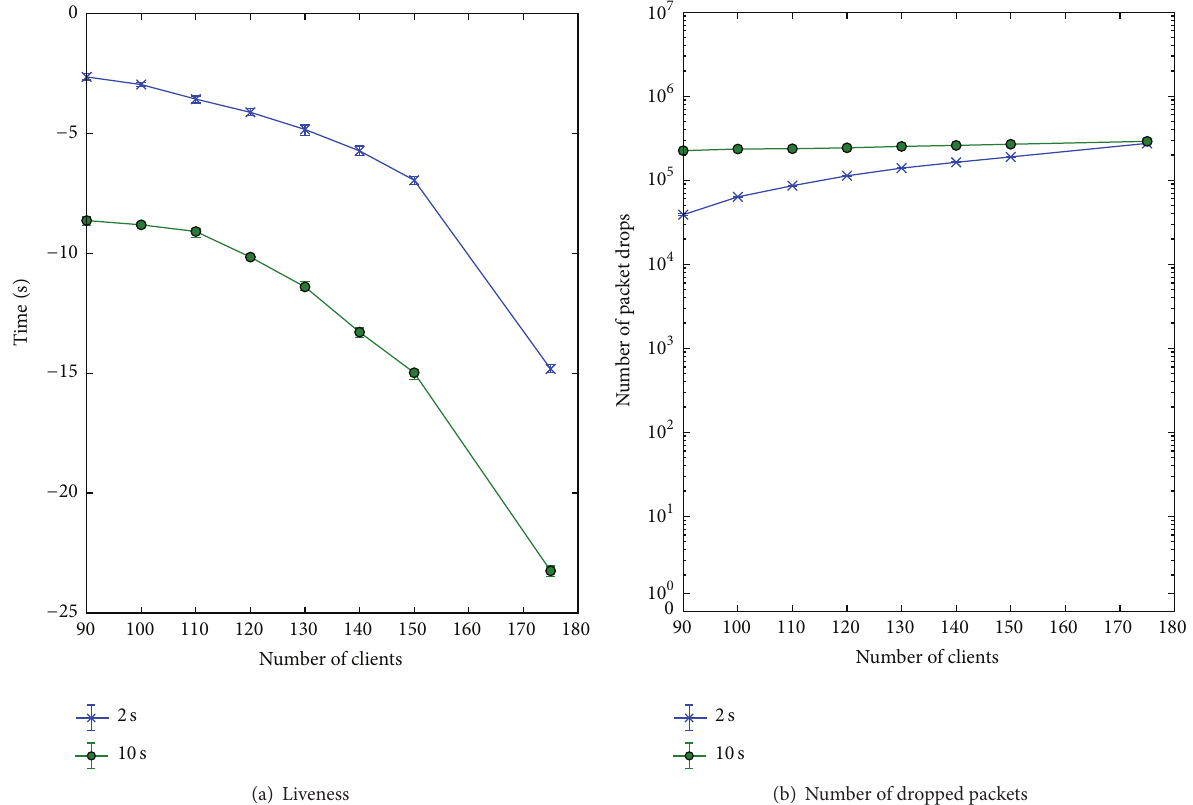
Figure 10: Performance of different segment